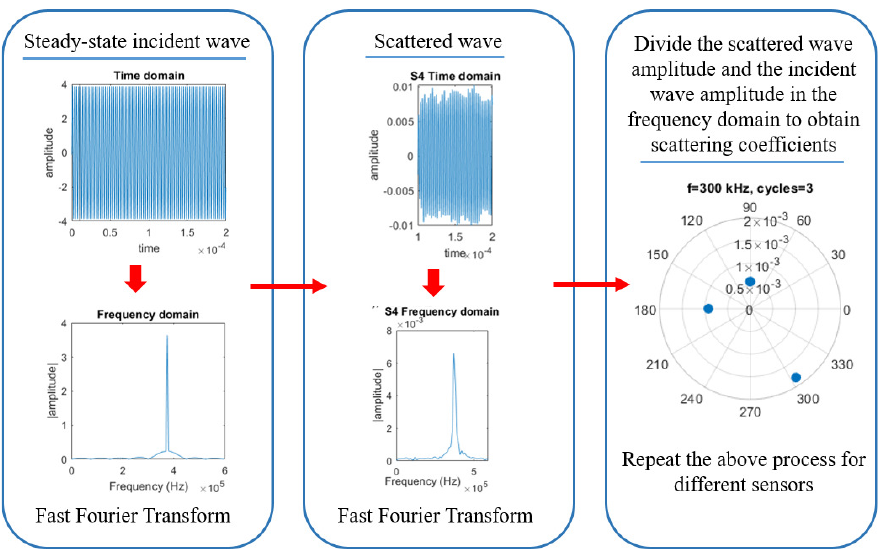
Figure 6. Workflow of signal processing technique used to obtain damage features in the frequency domain, namely, scattering